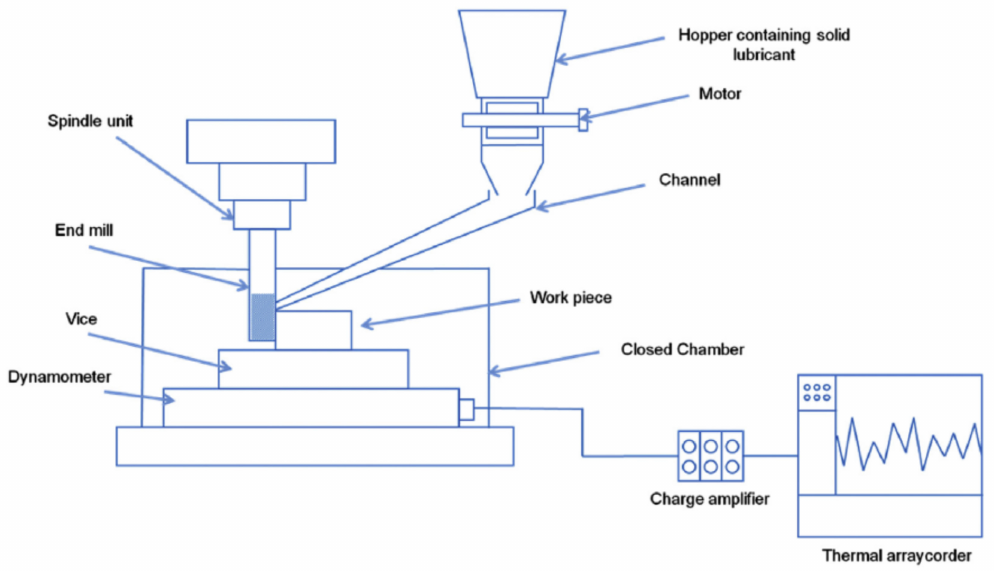
Figure 30. Lubricant feeding system, reprinted with permission from ref. [157]. Copyright 2005 Elsevier Ltd.